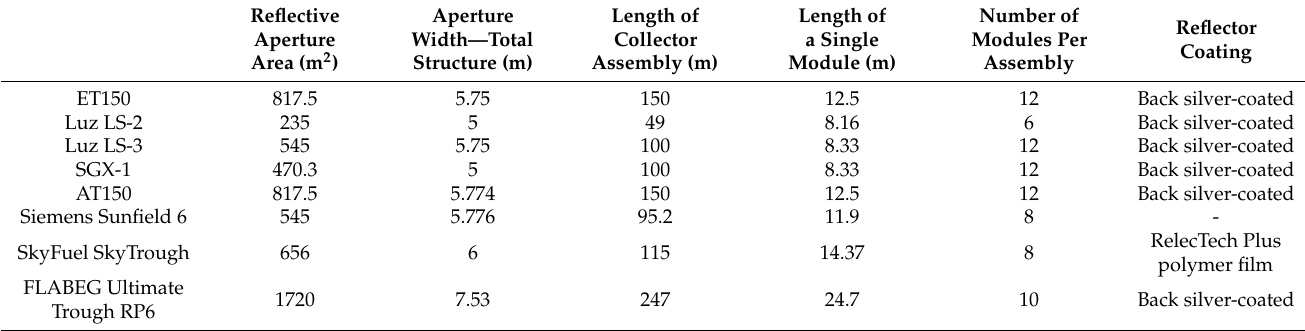
Table 1. Description of parameters for different various SCAs.